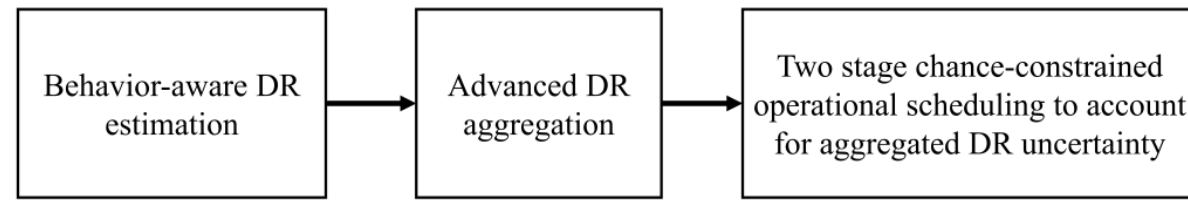
Figure 1. Flowchart of the work and scope of this paper.